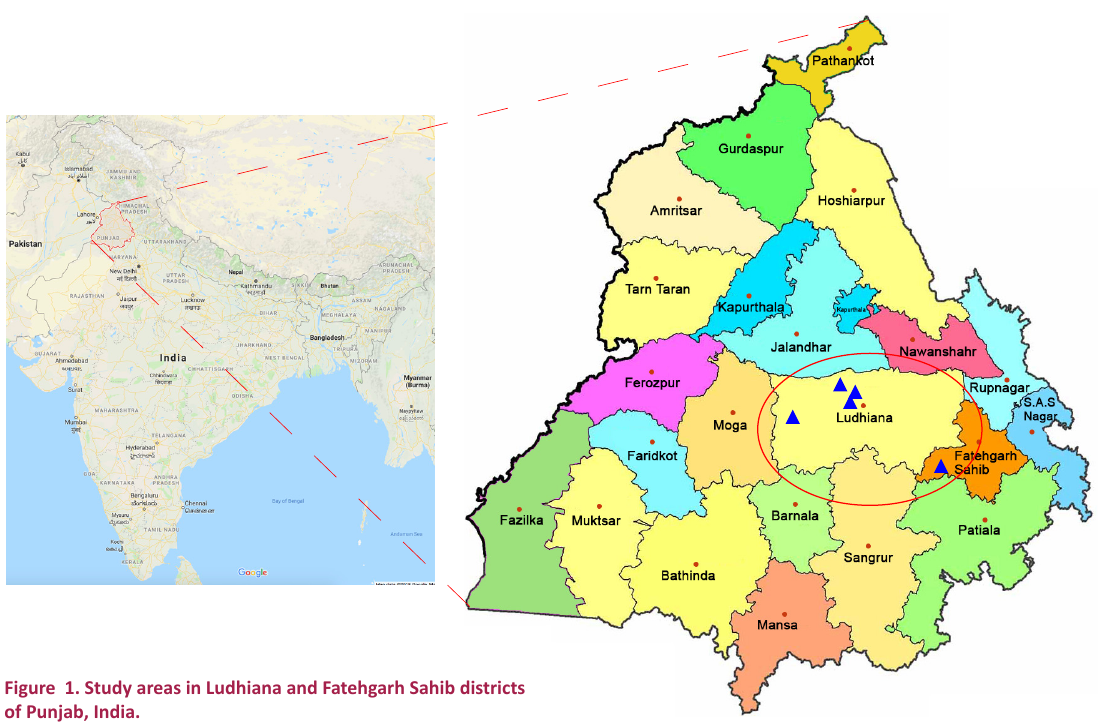
Figure 1. Study areas in Ludhiana and Fatehgarh Sahib districts of Punjab,